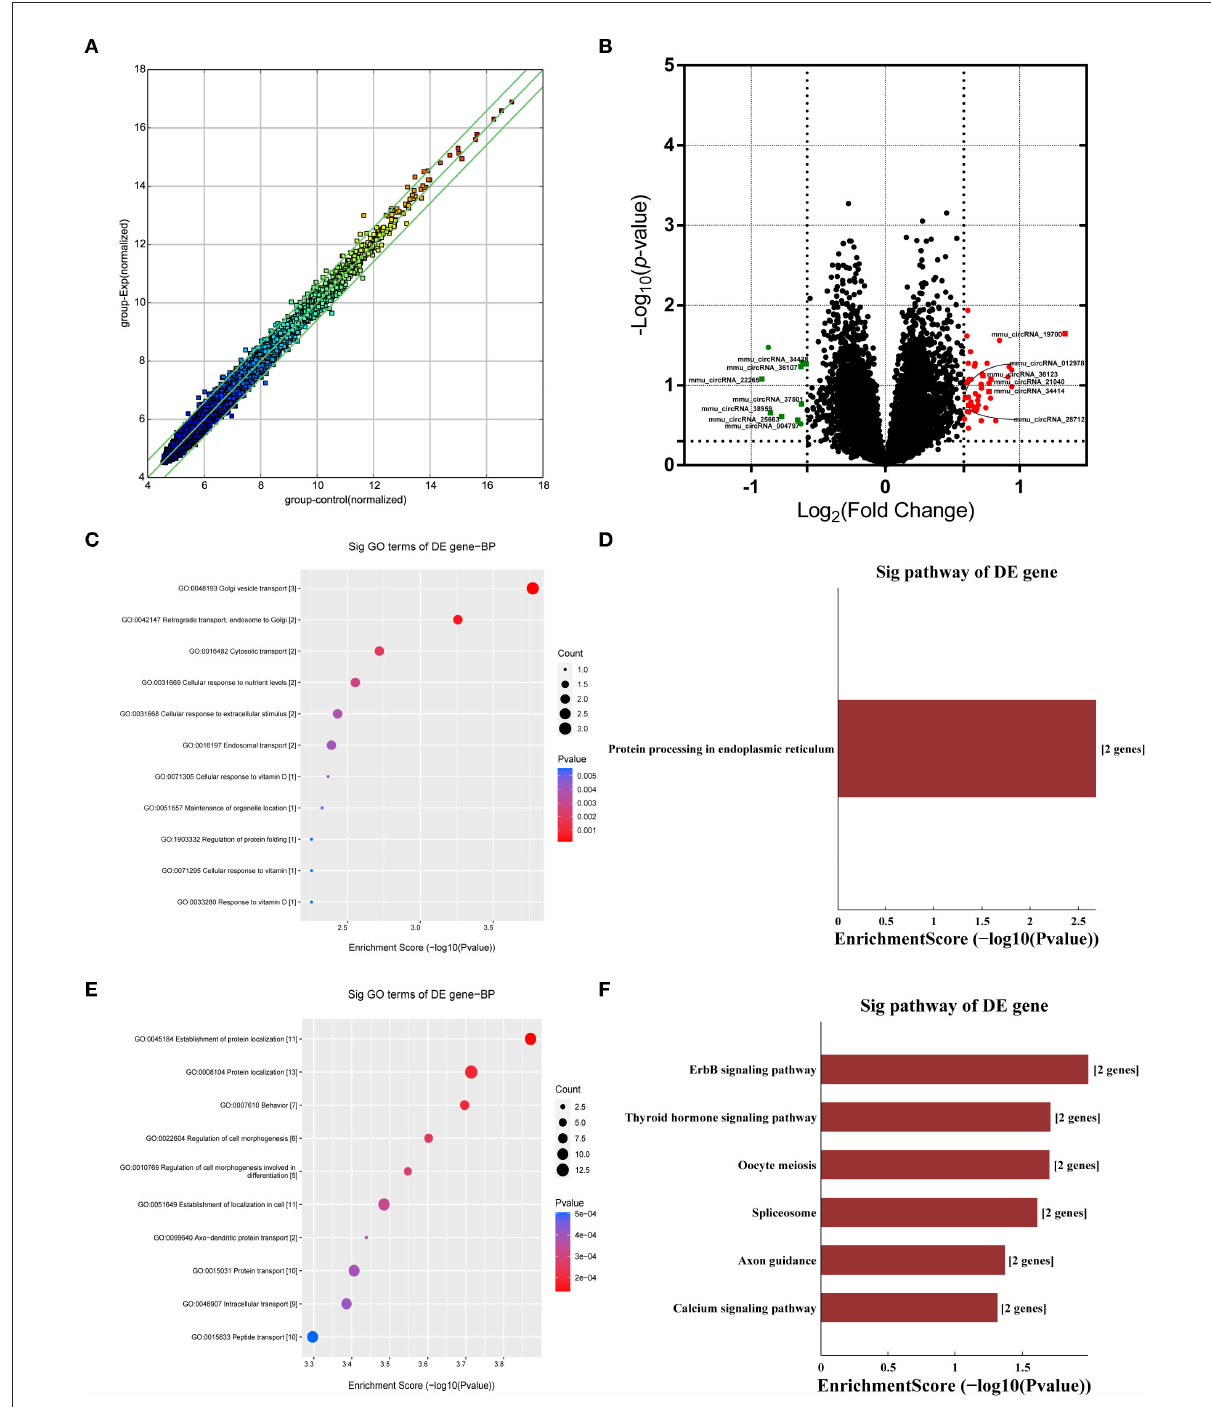
FIGURE5 Analysis of circRNA changes in the hippocampus. Five biological replicates of each group were applied in the experiment ( n = 5, 5). (A) The resulting scatter plot of circRNAs. (B) Volcano scatter plot of changed circRNAs. Generally, the horizontal axis is Log2 (fold change), The point is further off the center, and the greater the fold difference. The vertical axis is -Log 10 ( P -value), with points closer to the top of the graph and indicating more significant differences. (C) The enrichment score dot plot of BP terms in GO analysis of downregulated circRNAs. (D) The KEGG pathway analysis of downregulated circRNAs. (E) The enrichment score dot plot of BP terms in GO analysis of upregulated circRNAs. (F) The KEGG pathway analysis of upregulated